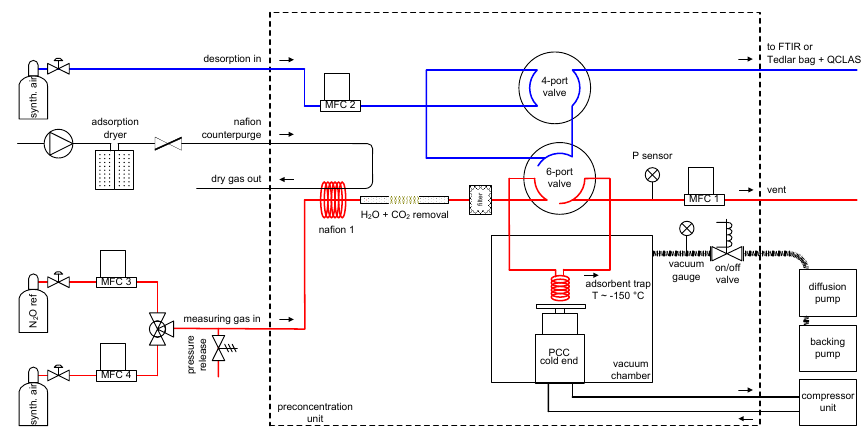
Fig. 1. Process chart during trap loading (phase II) with N 2 O in synthetic air.